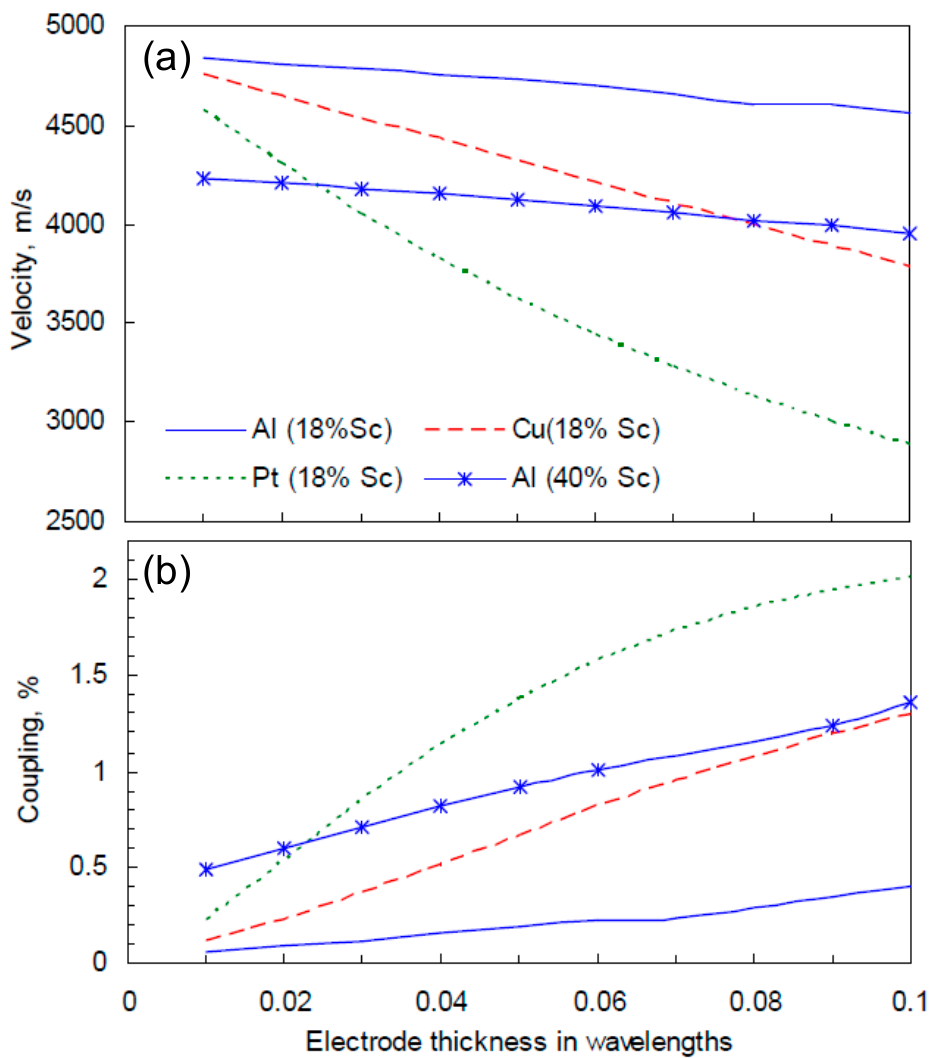
Figure 9. Simulated Rayleigh SAW velocities ( a ) and electromechanical coupling coefficients ( b ) in Sc x Al 1-x N/sapphire with Al, Cu or Pt grating and different Sc contents (x = 0.18 and 0.4).